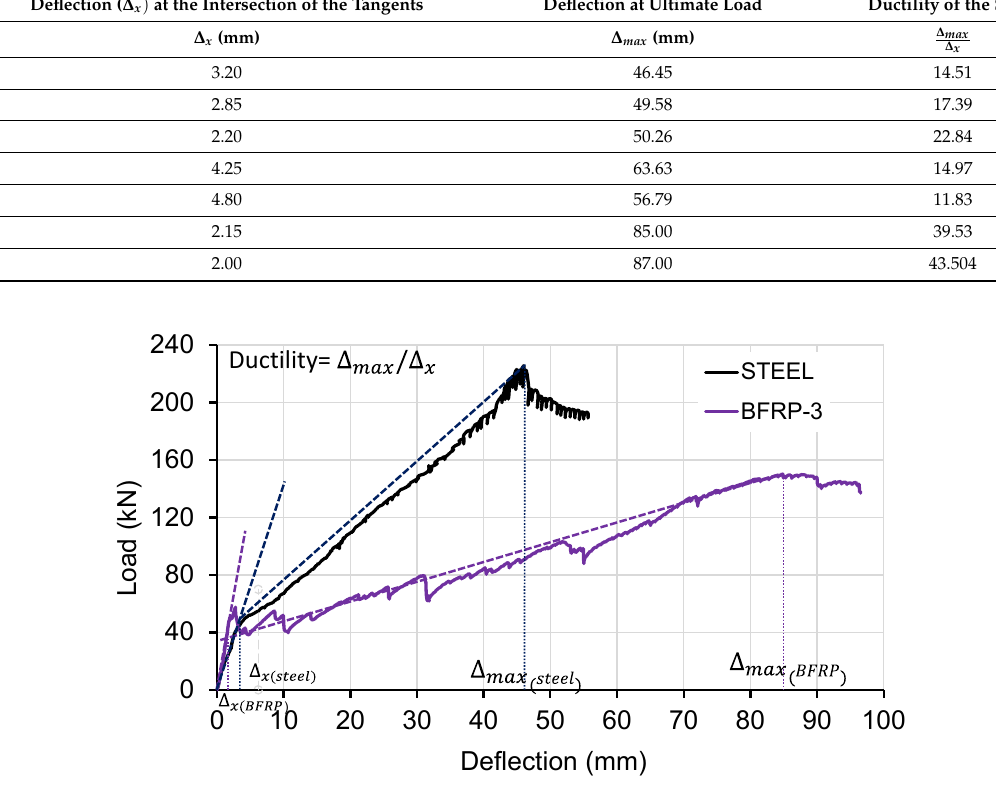
Figure 8. Method of determining displacement ductility of the slabs tested. Table 5. Displacement ductility of the slabs investigated.